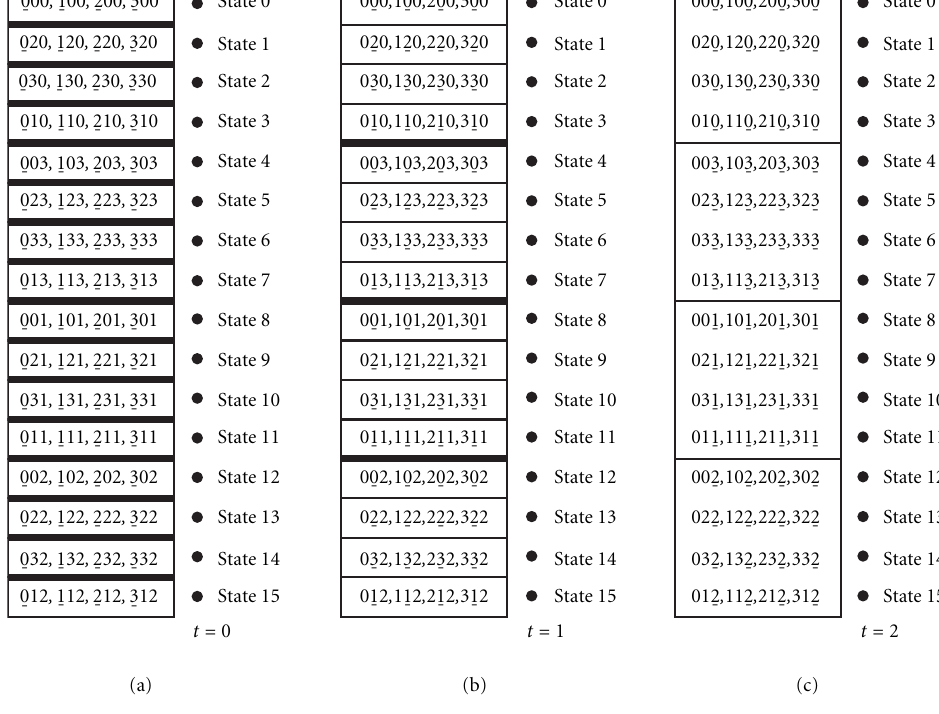
Figure 2: The group/subgroup structure of the example ST